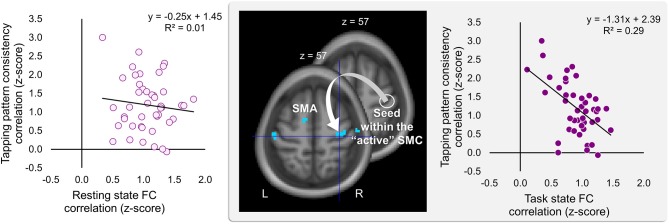
Inverse relationship between individual differences in degree of the tapping pattern consistency attained by the end of training and task-based FC strength within the “active” somatomotor cortex. The degree of consistency in the tapping pattern by the end of training was negatively correlated with the degree of the task-based FC within the hand area of the “active” somatomotor cortex (SMC) as well as between this region and the supplementary motor area (SMA). The whole-brain FC analysis was performed on the task state time-series using the ROI within the “active” SMC as a seed (the white circle); individual measures of the tapping pattern consistency were entered as a covariate of interest (middle panel). The degree of the tapping pattern consistency was assessed by averaging normalized Pearson's correlation coefficients between the tapping patterns generated during the last six blocks excluding block 14 (i.e., blocks 8–13) and the tapping pattern formed by the end of training (i.e., during block 14)—higher values indicating greater tapping pattern similarity and, therefore, greater consistency by the end of training. These coefficients are plotted against FC values extracted from the resting and task state time-series (left and right plot, respectively). The FC values were calculated between the ROI within the “active” SMC and the peak voxel of the significant cluster within the somatomotor hand area (xyz = 33, −21, 57) (the white arrow). The cyan blobs resulted from the statistical maps thresholded at p < 0.005 (two-tailed). L and R—left and right hemisphere, respectively.